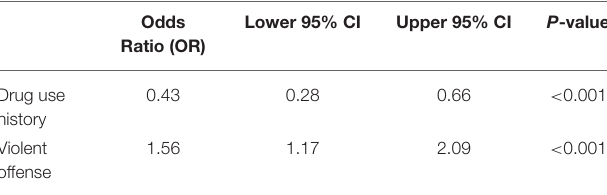
TABLE 2 | Logistic regression model identifying risk factors associated with the presence of PTSD among incarcerated women. Odds Lower 95% CI Upper 95% CI P -value Ratio (OR) Drug use 0.43 0.28 0.66 < 0.001 history Violent 1.56 1.17 2.09 < 0.001 offense PTSD, post-traumatic stress disorder.